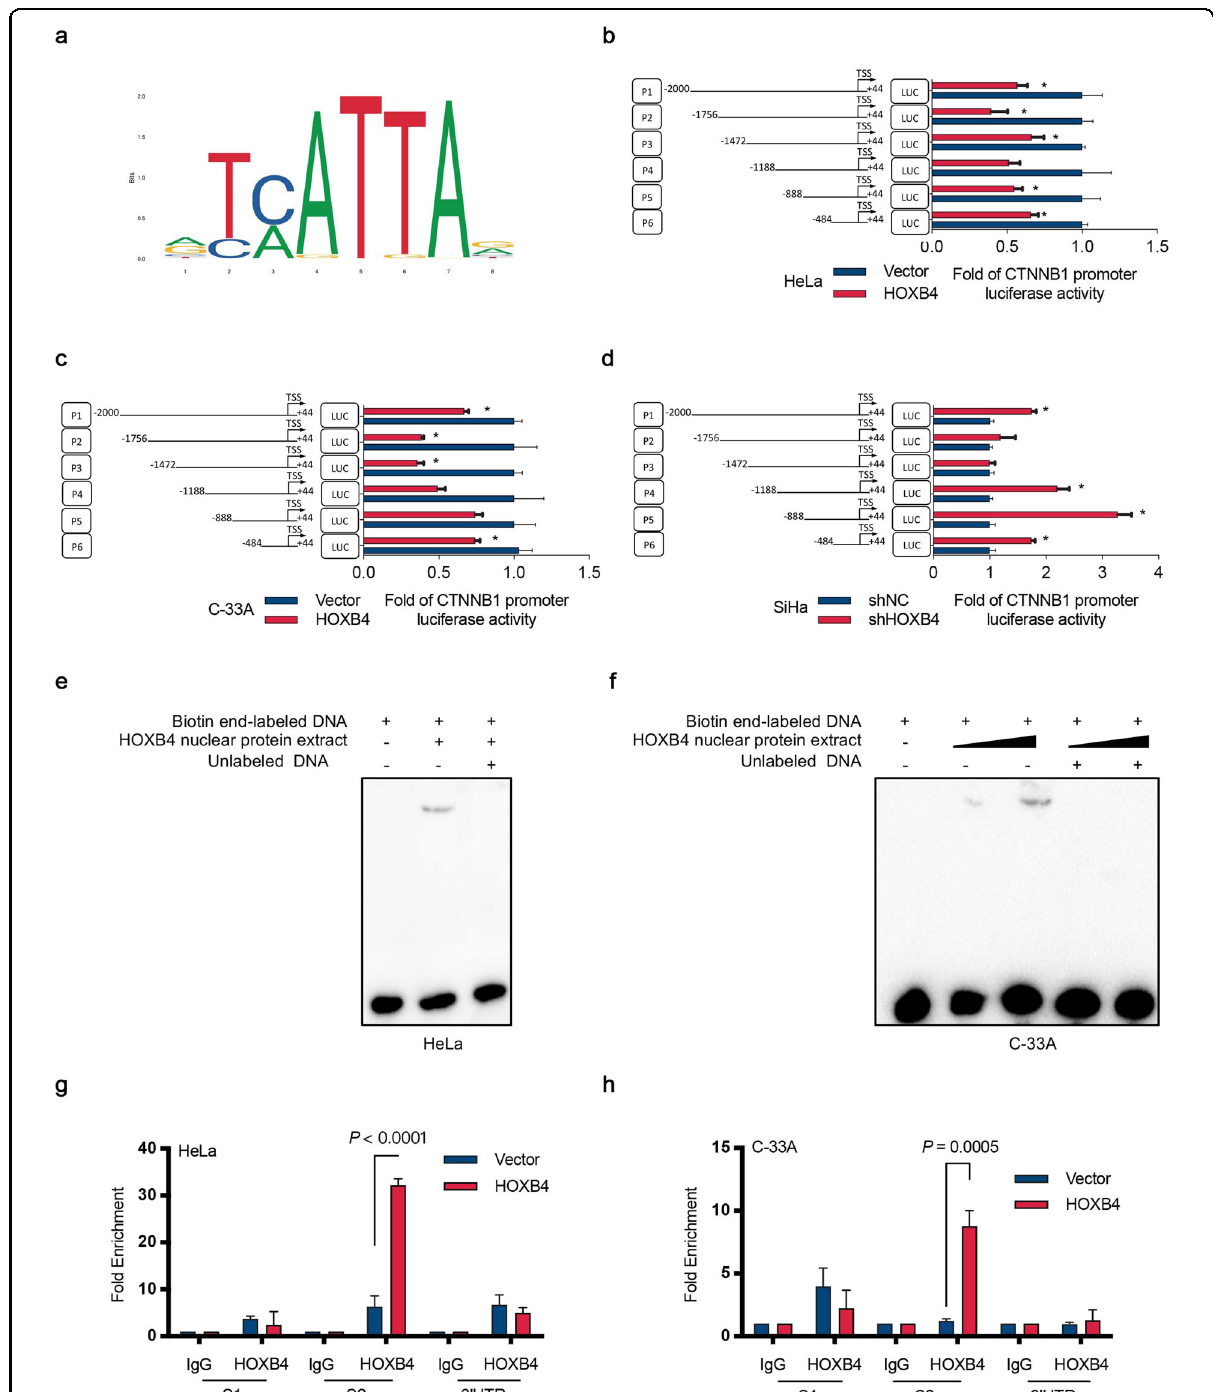
Fig. 5 HOXB4 bound to the promoter of β -catenin directly. a Transcription factor binding sites of HOXB4. b – d Luciferase assays assessing the promoter of β -catenin. β -catenin promoter fragments were constructed, and luciferase activity relative to the control was measured in HOXB4- modi fi ed HeLa ( b ), C-33A ( c ), and SiHa ( d ) cells. e , f EMSA assay for the promoter of β -catenin. EMSA was used to detect the direct association of nuclear HOXB4 protein with its binding sites on the promoter regions of β -catenin in HOXB4-overexpressing HeLa ( e ) and C-33A ( f ) cells. g , h ChIP assays for the promoter of β -catenin. ChIP-qPCR assay in HOXB4-overexpressing HeLa ( g ) and C-33A ( h ) cells were performed with HOXB4 antibody and IgG antibody (negative